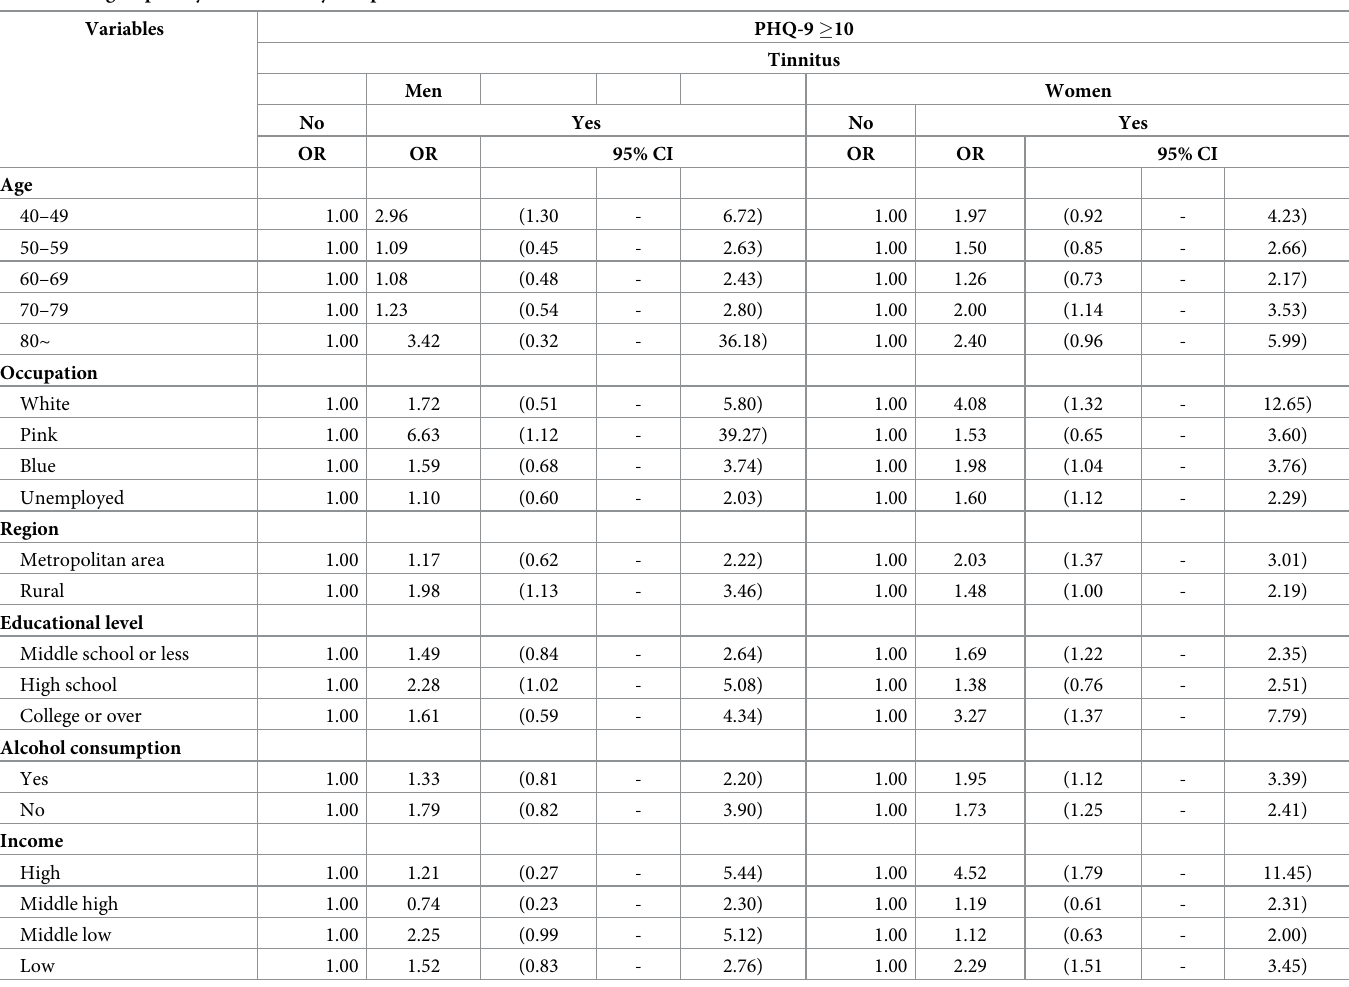
Table 4. Subgroup analysis stratified by independent